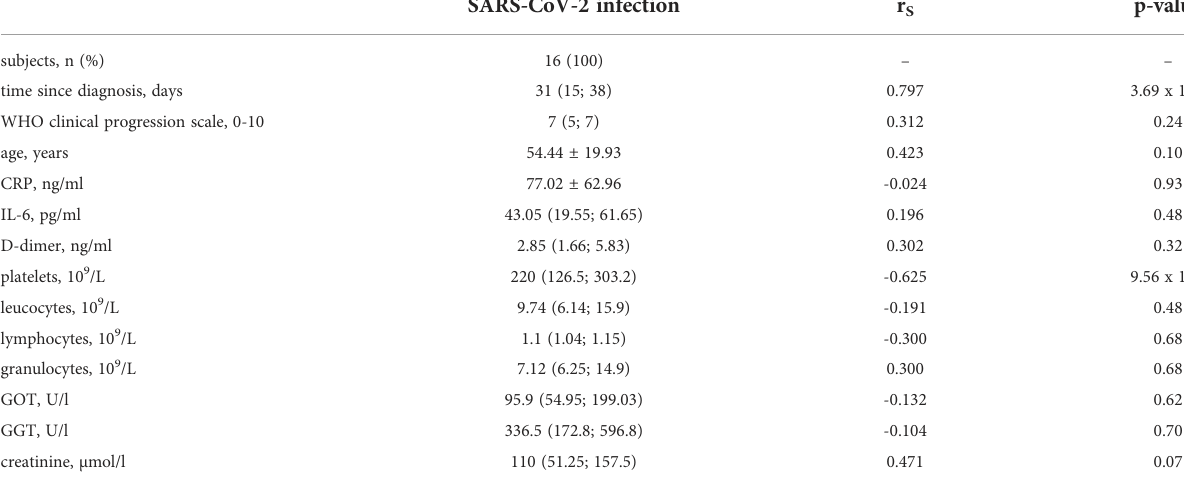
TABLE 2 Correlation analysis of CC16 withclinical measures and immunologicalserum markersin n = 16 patients treated for SARS-CoV-2 infection.